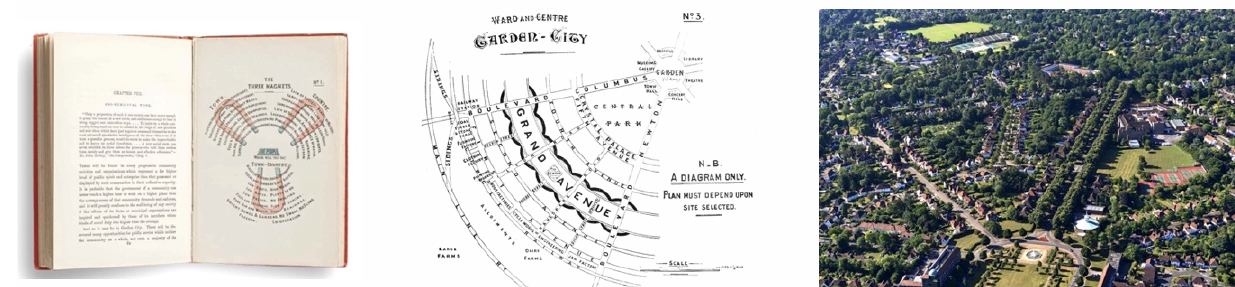
Figure 1. The garden cities model: as a theoretical archetype (left), as a model of intelligibility (centre) and as an example (right). Sources: Howard (1898); Letchworth Garden City Heritage Foundation,